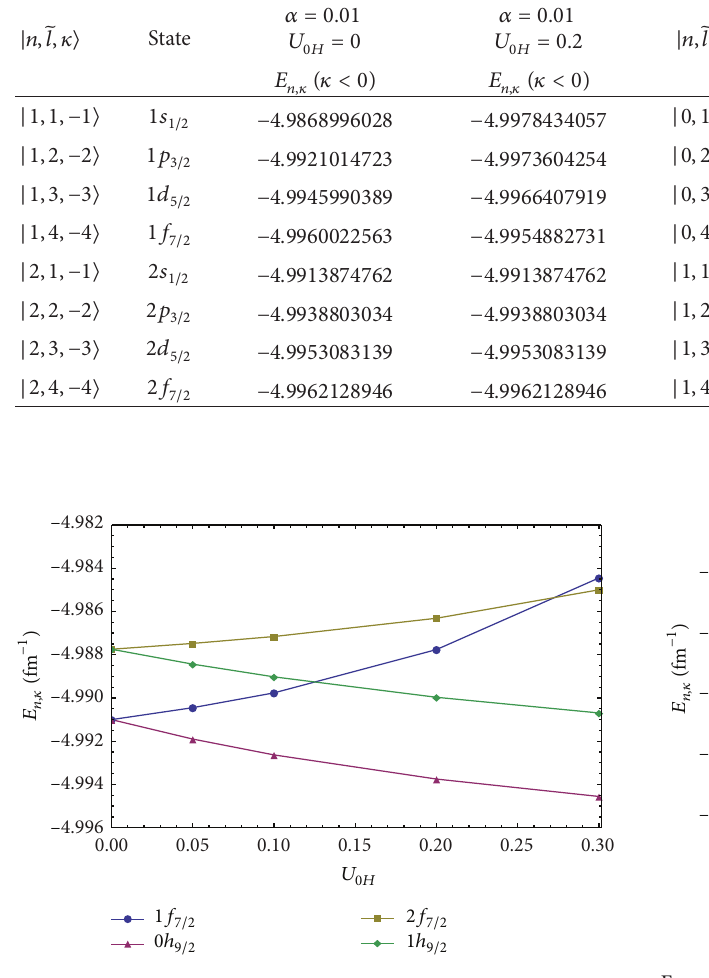
Figure 3: Contribution of the tensor Hulth´en potential parameter to the energy levels in the case of p-spin symmetry.